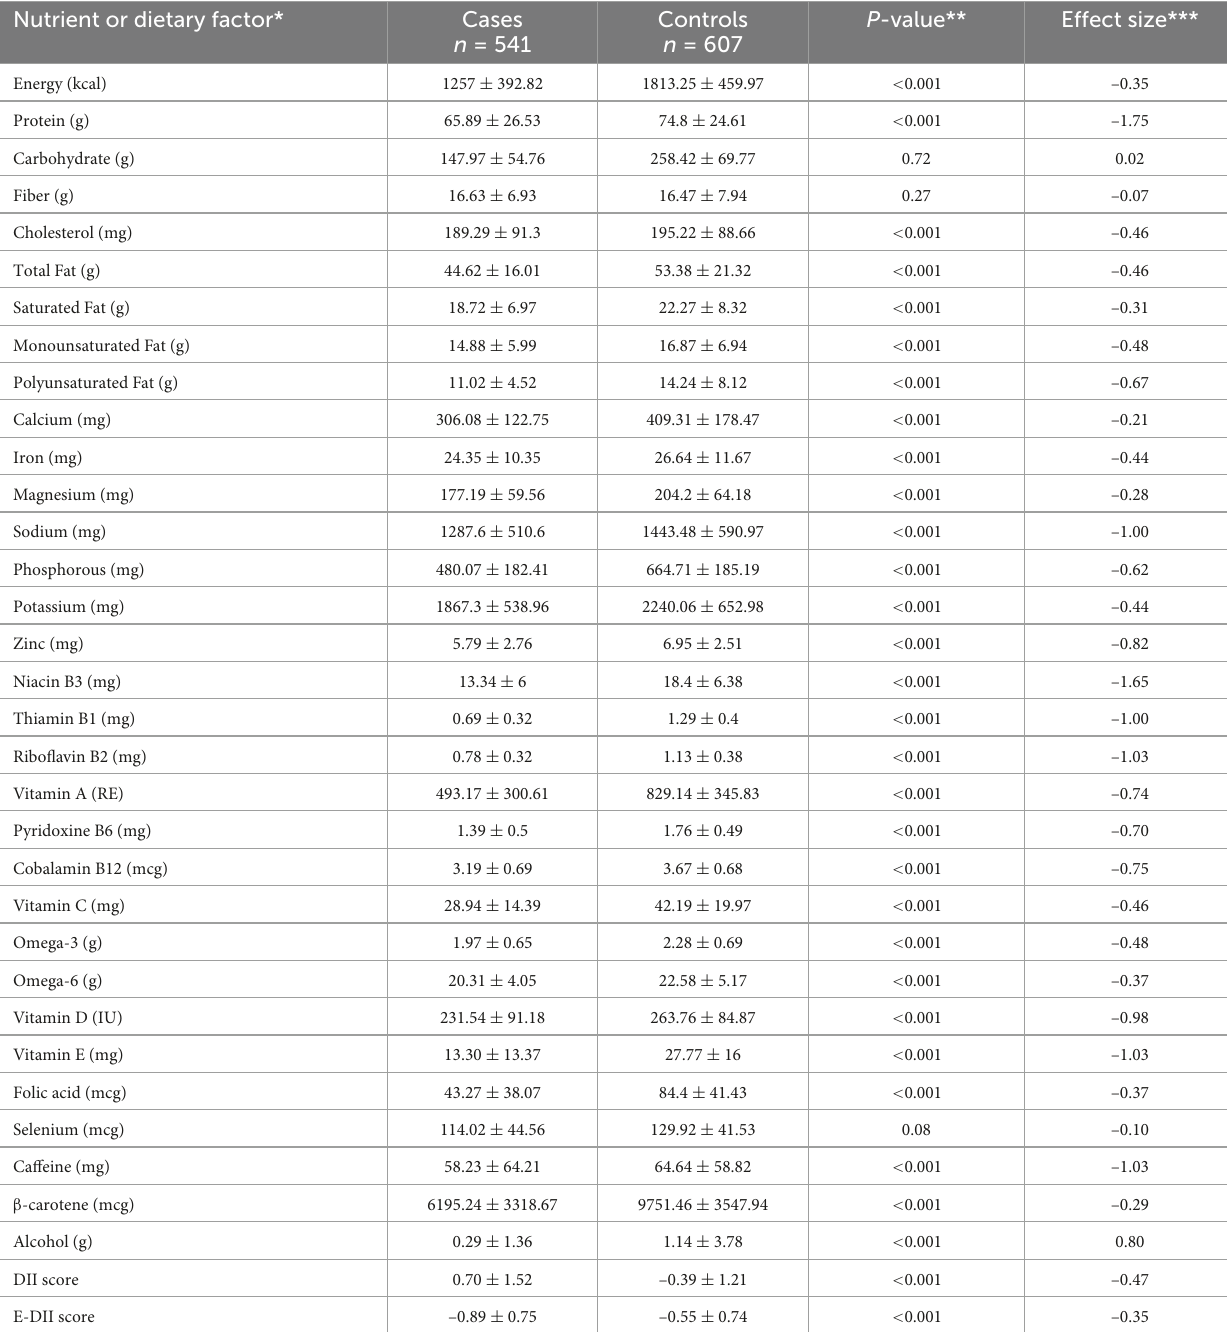
TABLE 2 Distribution of dietary factors, nutrients, dietary inflammatory index (DII), energy dietary inflammatory index (E-DII) for cases and control subjects. Nutrient or dietary factor*